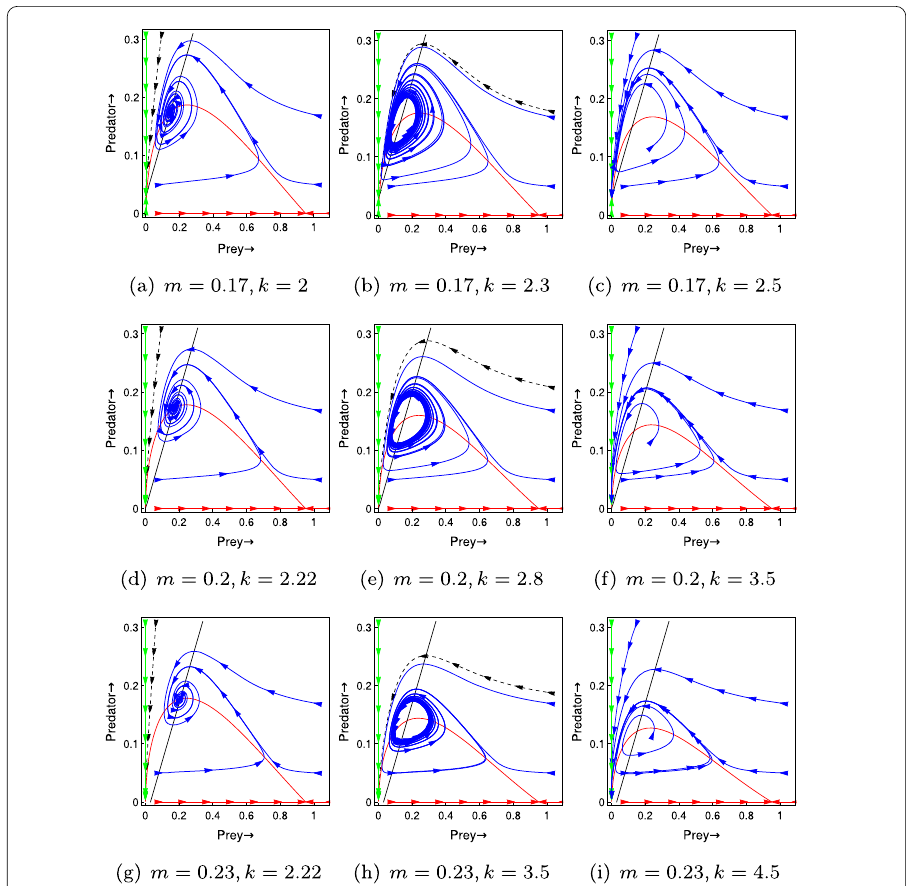
Figure 6 Phase portrait for system (2.4a)–(2.4b) for case (i) E 2 for m < c , we have ( a ), ( b ), and ( c ); for case (ii) E 4 for m = c , we have ( d ), ( e ), and ( f ); for case (iii) E 5 for m > c , we have ( g ), ( h ), and ( i ). Here ( a ), ( d ), and ( g ) are locally asymptotically stable; ( b ), ( e ), and ( h ) are periodic solutions; ( c ), ( f ), and ( i ) are unstable phase portraits. The red line represents prey nullcline, the black line represents predator nullcline, the red and green arrow lines represent stable trajectories along x and y axes respectively, which approach ˆ E and ¯ E . The black dashed arrow line represents the separatrix curve separating the trajectories which approach ¯ E and interior equilibria E 2,4,5 in the x-y